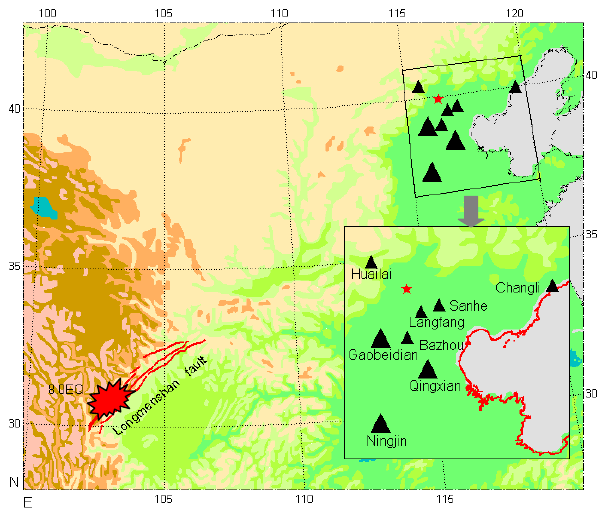
Figure1 Distribution of the Wenchuan EQ epicenter and observation stations. Black solid triangles show the related locations of observation stations in Hebei electromagnetic observation network and bigger ones indicate the stations where abnormal information was recorded. The red star denotes Beijing.